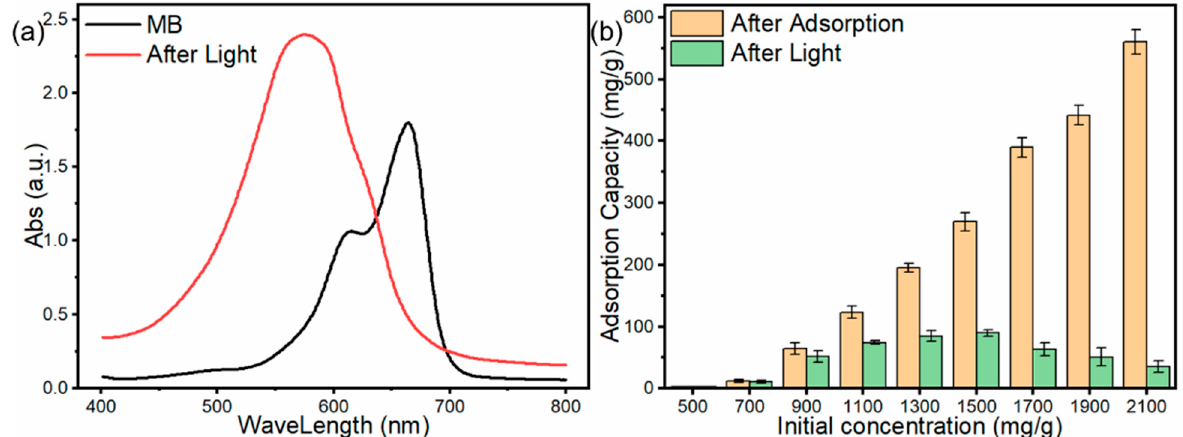
Figure 17. ( a ) UV spectra of MB before and after light exposure, ( b ) MB removal capacity at the different initial concentrations in the solution after adsorption and photocatalytic capacity after light exposure.